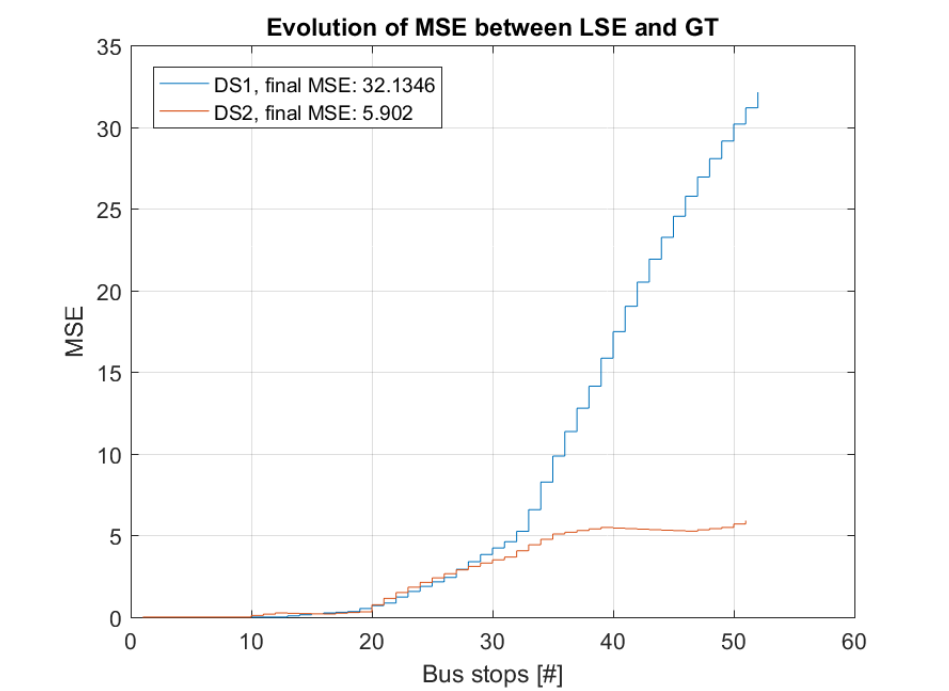
Figure 7. Evolution of MSE between LSE estimated occupancy and GT occupancy for two bus trips. Results are shown for the bus trips in data sets 1 and 2 (DS1 and DS2),